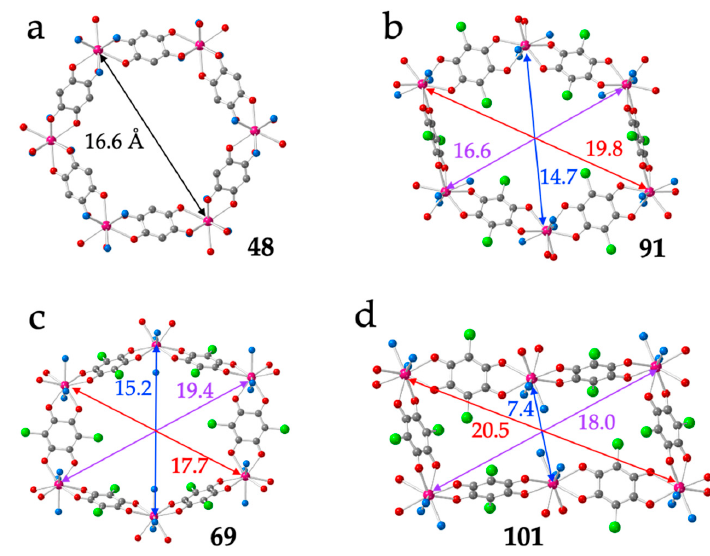
Figure 5. ( a ) Regular hexagonal ring in compound 48 showing the orientation of the anilato rings with respect to the mean plane of the ring. ( b ) Distorted hexagonal ring in compound 91 showing four face-on ( FO ) and two edge-on ( EO ) anilato rings. ( c ) Distorted hexagonal ring in compound 69 showing the two FO and four EO anilato rings. ( d ) Rectangular ring in compound 101 showing the two FO and four EO anilato rings. The distances corresponding to the different diagonals are in Å. Colour code: Ln = pink, C = grey, Cl = green, O anilato = red and O solvent = blue.